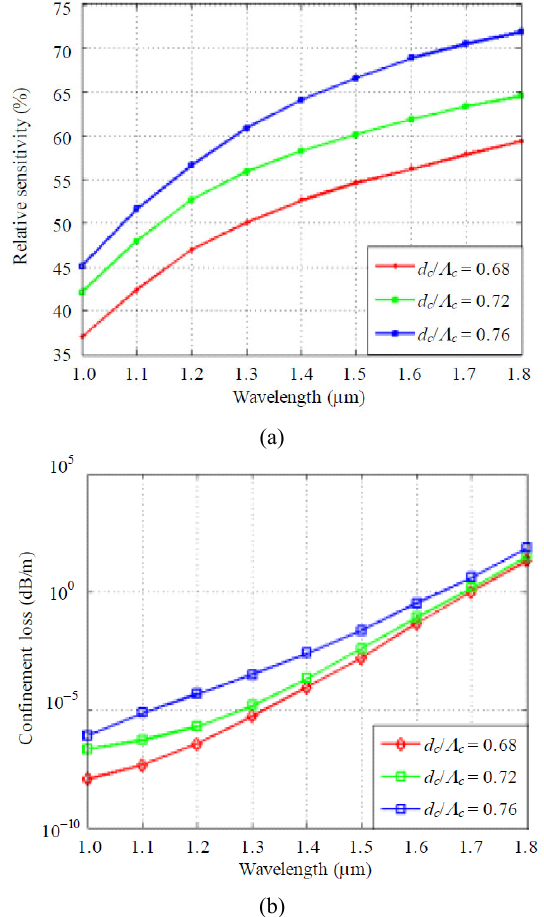
Fig. 5 Comparison between: (a) relative sensitivity versus wavelength and (b) confinement loss versus wavelength curve for the proposed H-PCF for optimized parameters:  = 3.00  m;  c = 1.08  m; d = 2.85  m and d c 0 = 1.08 μ m; d c /  c = 0.68, 0.72, and